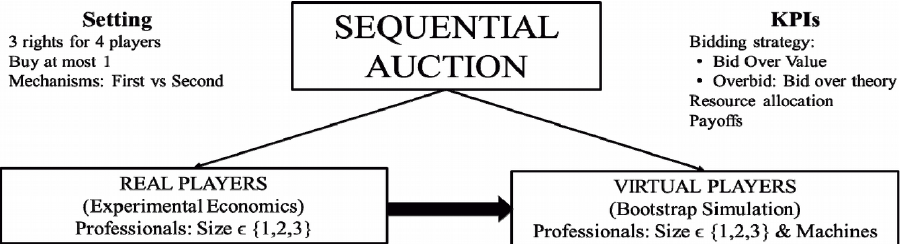
Figure 1. The business game and the experimentation framework